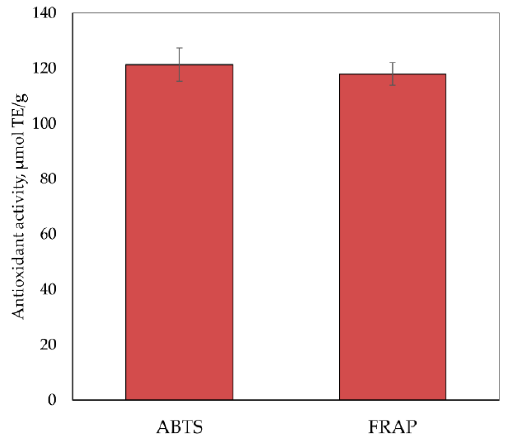
Figure 3. Antioxidant activity of cranberry ethanol extracts. Table 1. Compositions of the cranberry lyophilizate-containing